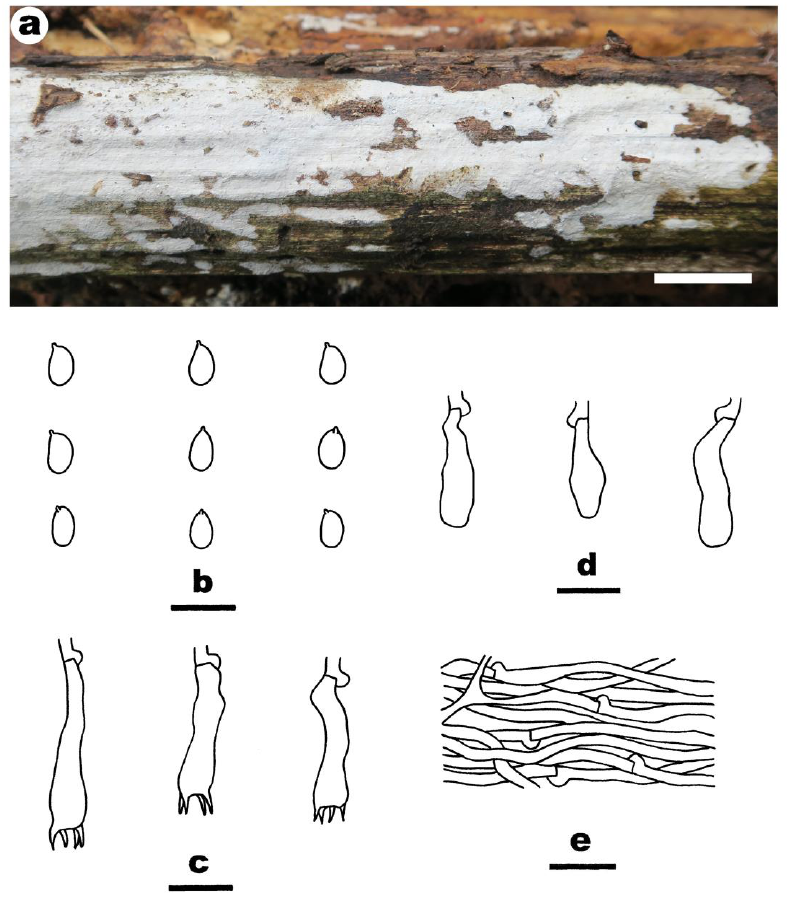
Figure 9. Effusomyces thailandicus (( a ) from BJFC 023568; ( b – e ) from the holotype BJFC 023496). Scale bars: ( a ) = 1 cm; ( b – e ) = 10 µm. ( a ). Basidiomes; ( b ). Basidiospores; ( c ). Basidia; ( d ). Basidioles; ( e ). Hyphae from